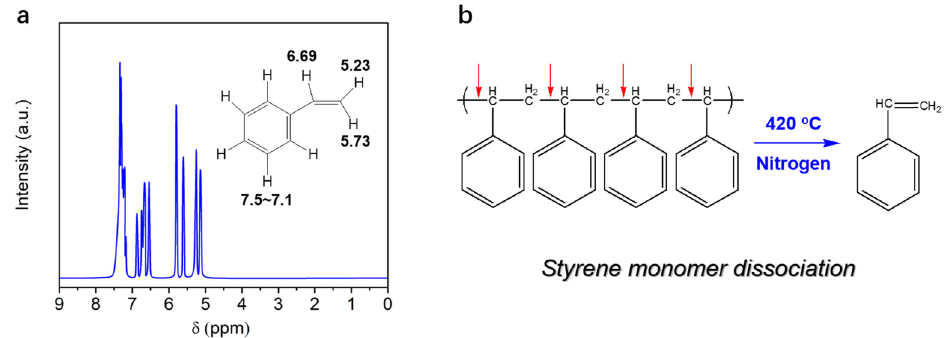
Figure 4: ( a ) HNMR spectra of the single component in liquid product from pyrolysis of polystyrene. ( b ) Styrene monomer dissociation mechanism of polystyrene